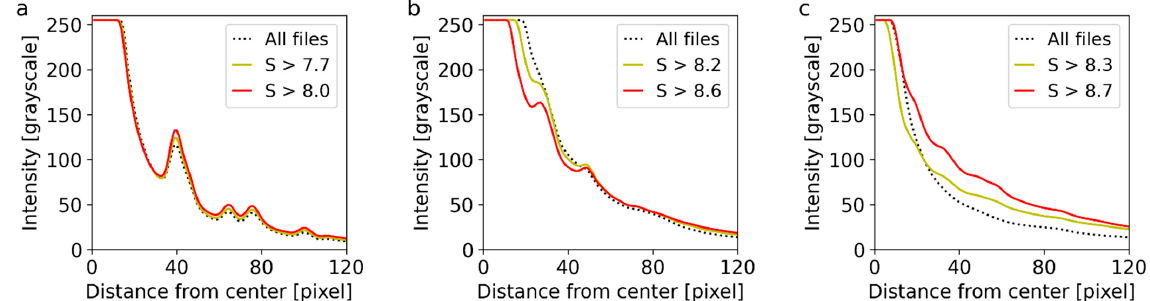
Figure 9. The influence of filtering on the final 4D-STEM/PNBD diffractogram of: ( a ) Au, ( b ) TbF 3 , and ( c ) NaYF 4 . In all graphs, the dotted line represents radially averaged intensity from the full dataset (Au big, TbF 3 , or NaYF 4 , Table 1), the yellow line represents the intensity after filtering out files containing just a few weak diffraction spots, the red line represents the intensity after keeping only the files with strong diffraction spots, and S stands for Shannon entropy value, as explained in Section 3.2.